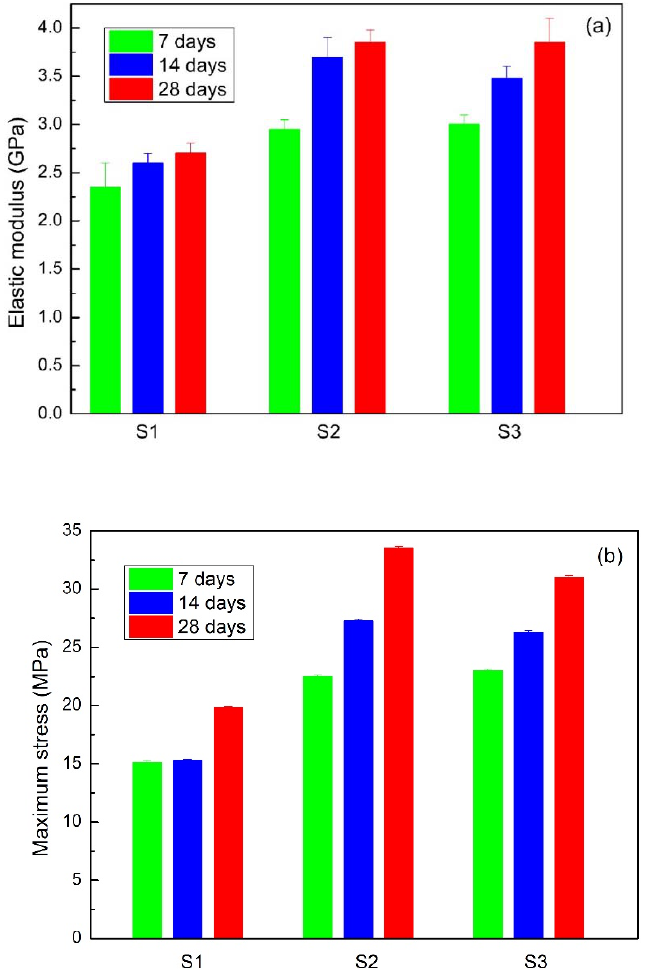
Figure 11. ( a ) Elastic modulus and ( b ) maximum stress to S1, S2, and S3 samples.